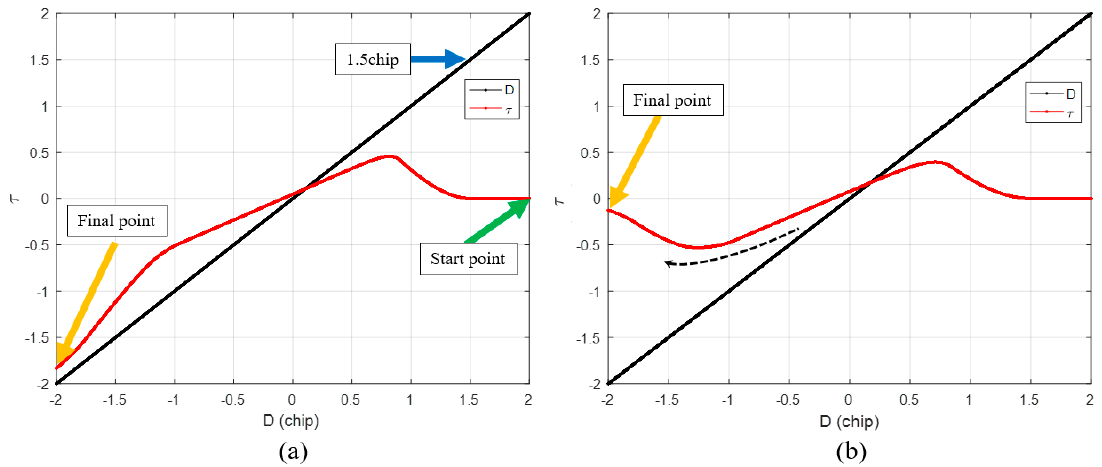
Figure 4. Calculated histories of the local replica code phase in case of ( a ) successful spoofing attack; ( b ) spoofing attack failure.